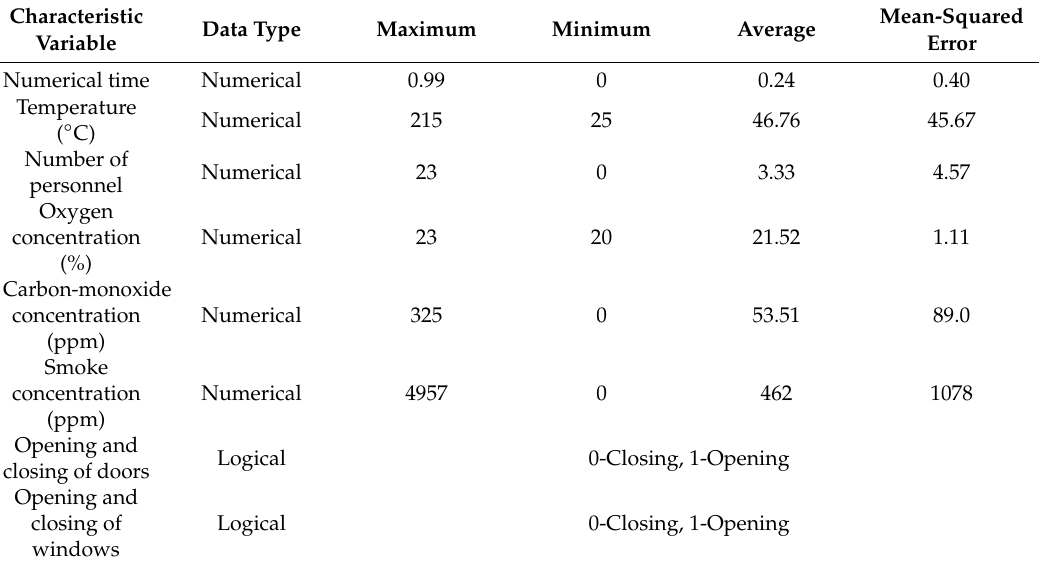
Table 4. Types of influencing factors and quantitative results.